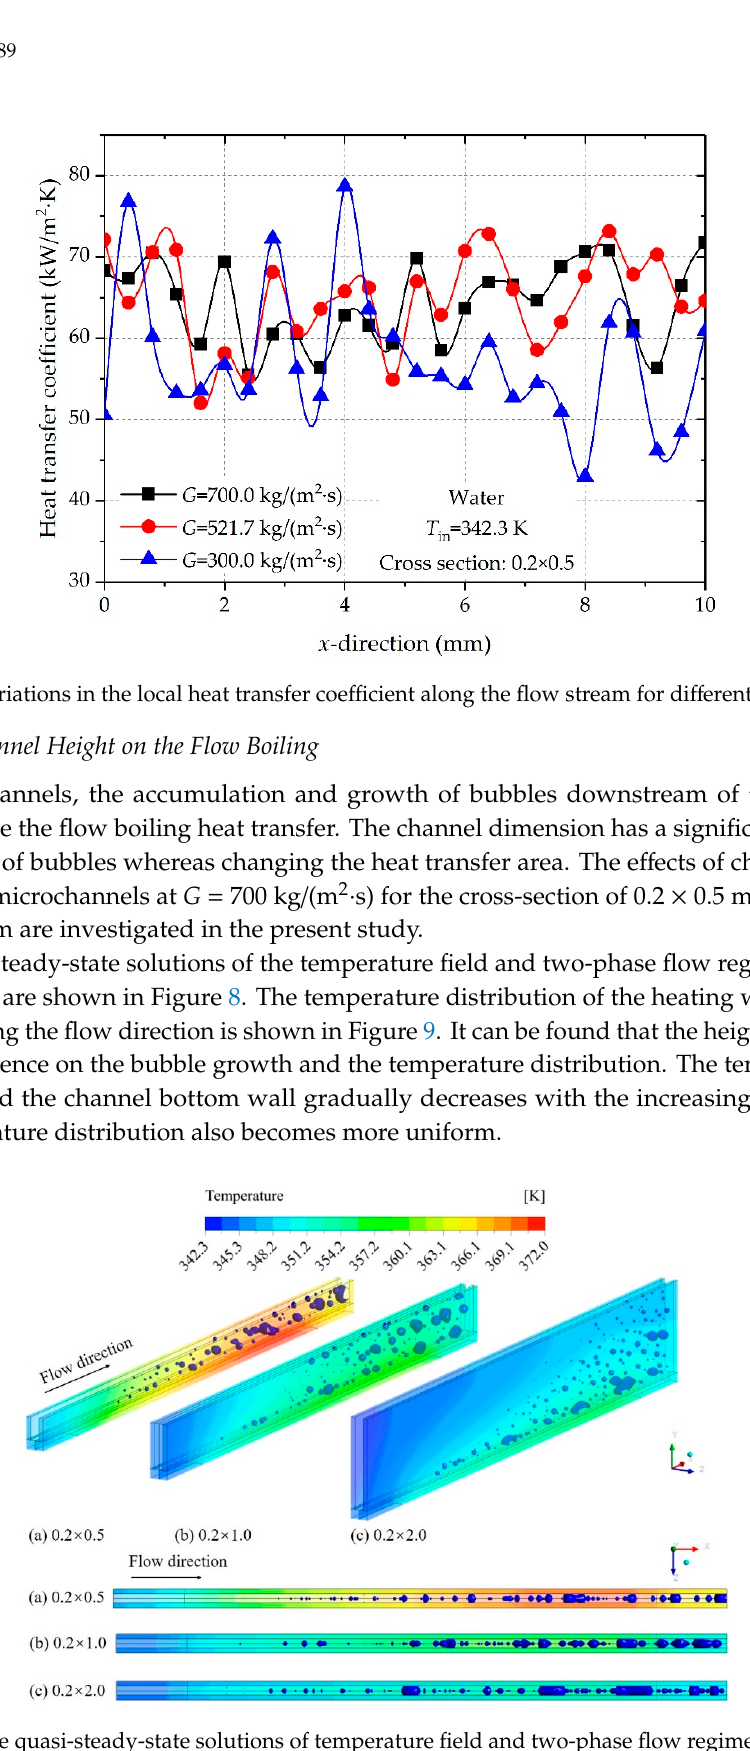
Figure 6. The quasi-steady-state solutions for temperature field and two-phase flow regime for different mass fluxes.